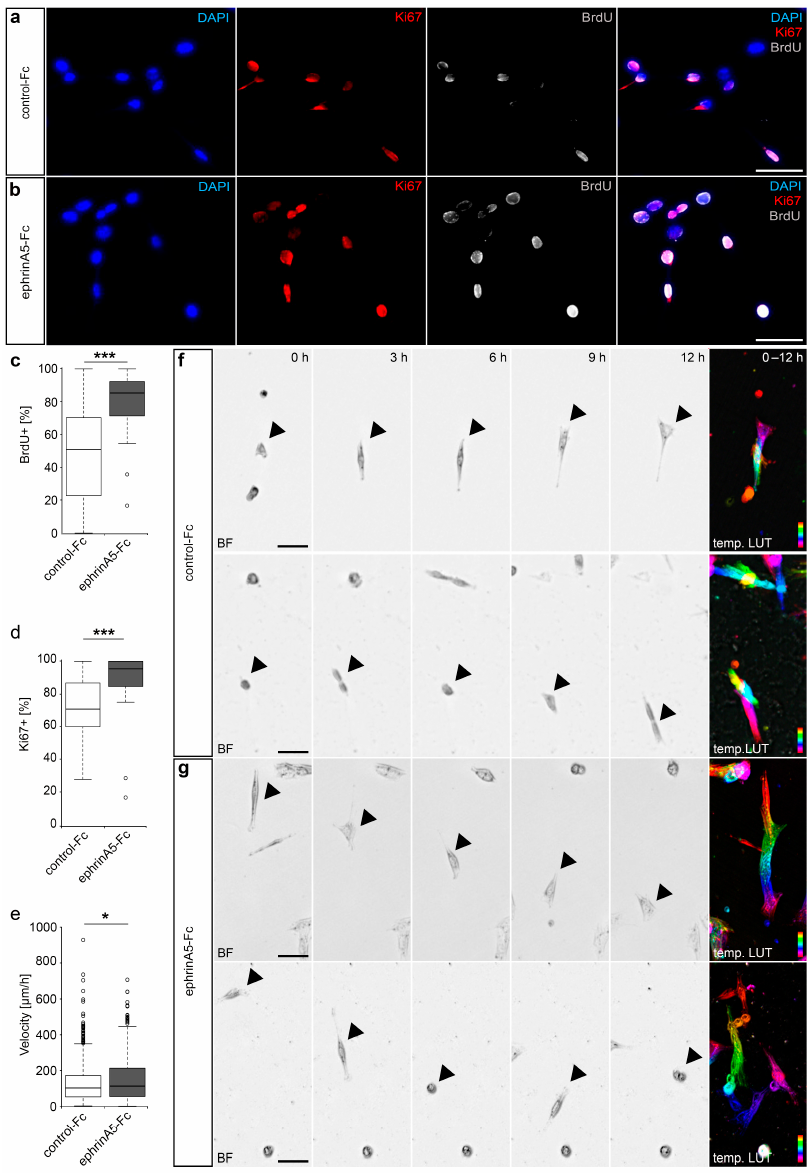
Figure 3. EphrinA5-Fc stimulation results in increased proliferation and motility of CB cells. ( a , b ) CB 3 cells treated with control-Fc ( a ) or recombinant ephrinA5-Fc ( b ), both clustered with an Alexa488 conjugated anti-human IgG antibody, were stained with DAPI (blue, first panel) and antibodies directed against Ki67 (red, second panel) and BrdU (grey, third panel). The overlay of all channels is depicted in the fourth panel. ( c ) Quantitative analysis of the proportion of BrdU positive cells, with BrdU pulses given one hour prior to fixation of cells. ( d ) Quantitative analysis of the proportion of Ki67 positive cells ( n = 645 cells for control-Fc and n = 451 cells for ephrinA5-Fc; N = 3 experiments). ( e – g ) Live cell imaging analysis of migrating CB cells treated with ephrinA5-Fc and control-Fc revealed increased velocities upon ephrinA5-Fc stimulation as quantified in ( e ); n = 618 cells for control-Fc and n = 576 cells for ephrinA5-Fc; N = 3 experiments). ( f , g ) Representative brightfield images of temporal sequences illustrating the migratory route of selected CB cells after treatment with control-Fc ( f ) and ephrinA5-Fc ( g ), depicting frames at 0 h, 3 h, 6 h, 9 h, and 12 h of the respective cell track. The last panel in ( f , g ) represents the color-coded migratory distances within the depicted 12 h time period (temporal LUT), indicating the starting point (red, top) and the end point (magenta, bottom) of the respective cell. Two-tailed Student’s t -test, * p < 0.05, *** p < 0.001. Scale bars 50 µ m. BF: brightfield, temp. LUT: temporal LUT, Ctrl: